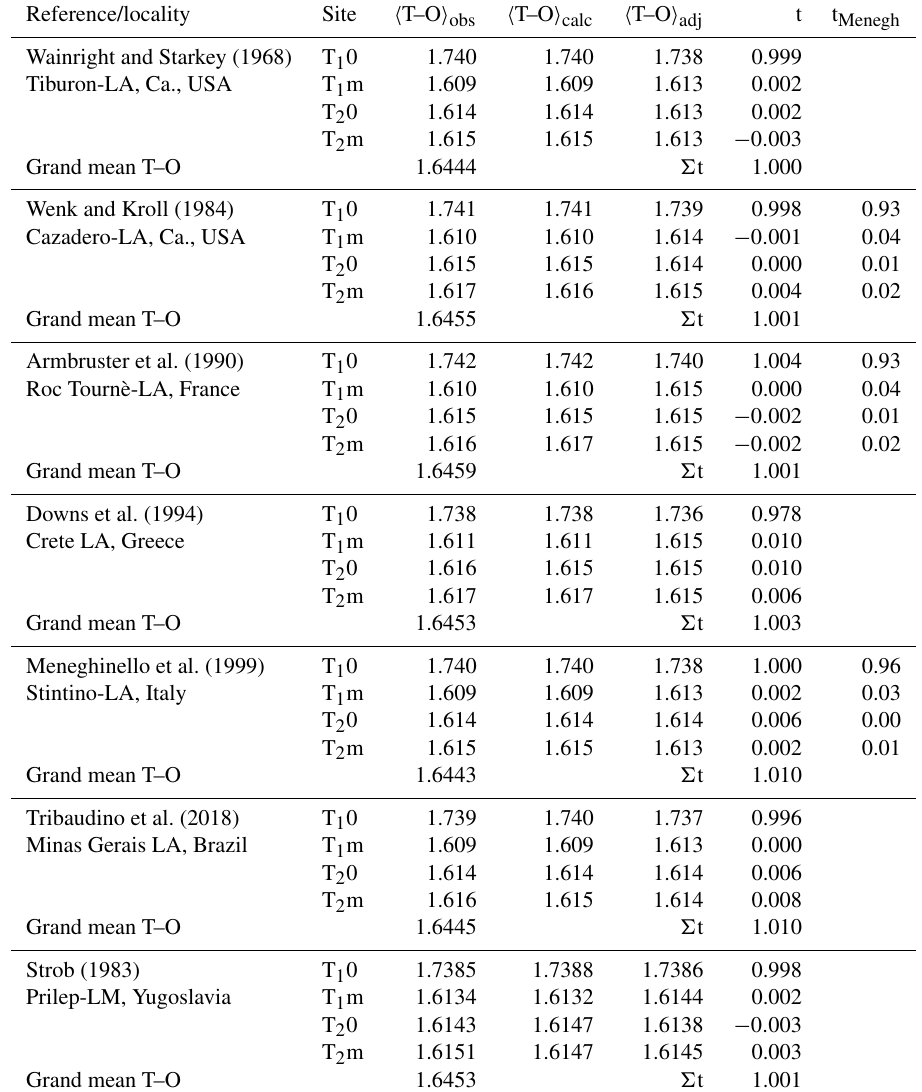
Table 1. Mean tetrahedral distances, (cid:104) T–O (cid:105)[ Å ] , and Al site occupancies, t, of six low albites and one low microcline. (cid:104) T–O (cid:105) calc = (cid:104)(cid:104) T–O (cid:105)(cid:105)+ c 3 [ t − 0 . 25 ( 1 + n An ) ]+ c 4 (cid:49) (cid:104) f s ( O ) (cid:105) (Eq. 8). (cid:104) T–O (cid:105) adj and t come from Eq. (9) ( (cid:54) t = 1 + n An ). Site occupancies t Menegh from Meneghinello et al. (1999) are listed for